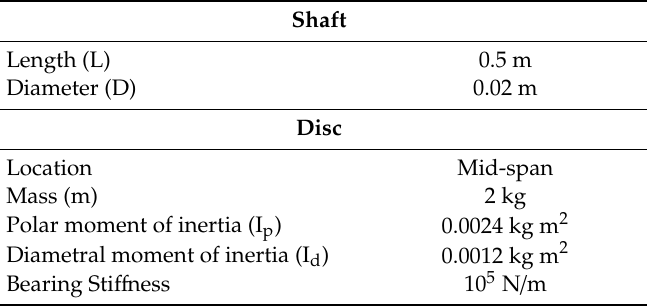
Table 6. Data used in the present